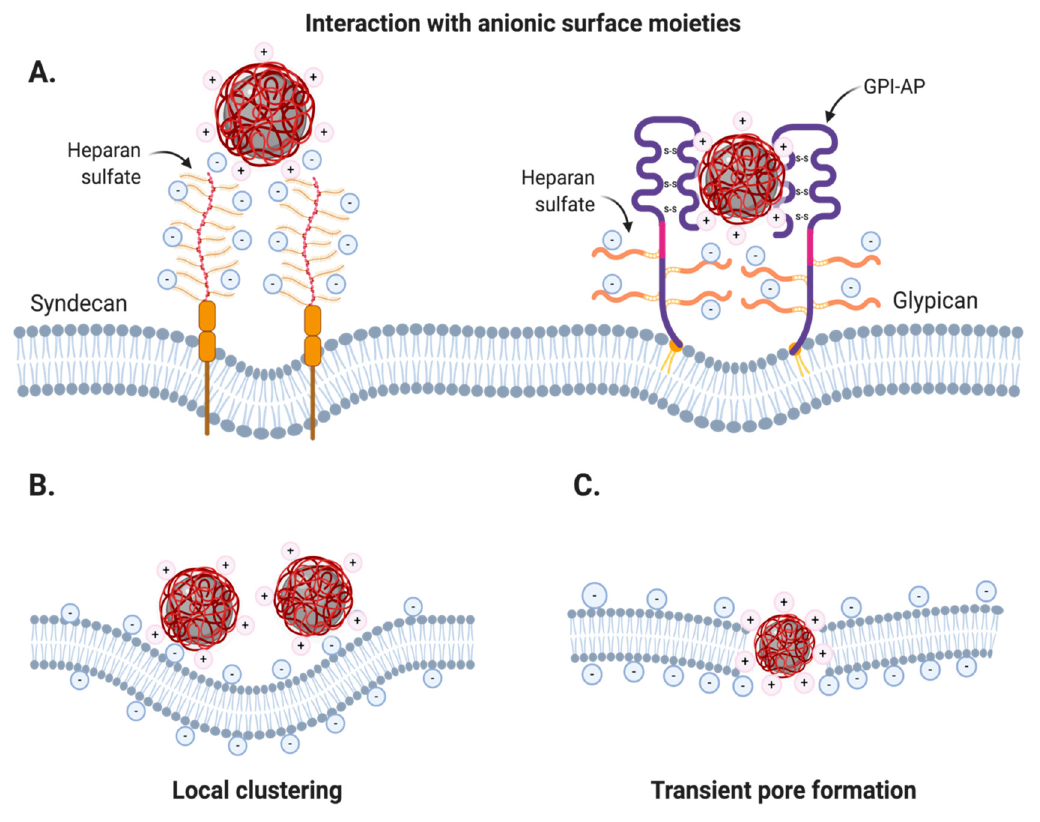
Figure 2. Adsorptive interactions between charged nanoparticles (CNPs) and the plasma membrane. ( A ) Electrostatic interactions with anionic syndecans and glypicans rich in heparan sulfate. ( B ) Cooperative membrane wrapping phenomena by cumulative CNP interactions with anionic phospholipids. ( C ) Transient pore formation by small CNPs ( ≤ 20 nm) due to strong attraction to the inner membrane layer in phosphatidylserine-rich regions. (Created with BioRender.com).